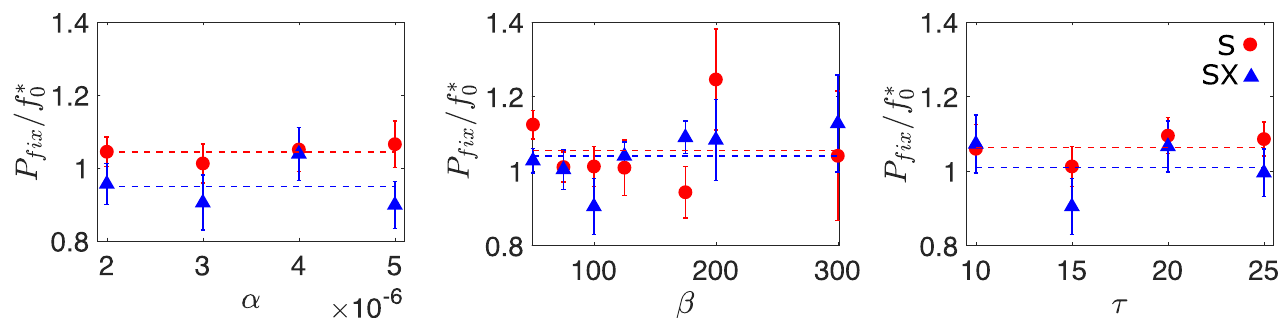
Fig 3. Fixation of neutral mutants. Probability of mutant fixation P in the superinfecting (S) and non superinfection excluding (SX) scenarios, scaled by the fix initial frequency of the mutant f � ¼ 1 = ð V þ b I Þ , as a function of adsorption rate α , burst size β and lysis time τ . Dashed lines indicate the average of the data 0 ss ss for both the superinfecting (blue) and superinfection-excluding (red) scenarios. These lines indicate that neutral mutants in superinfecting populations experience a small advantage over mutants in an equivalent superinfection-excluding population. Unscaled P fix data can be seen in S2 Appendix. Unless otherwise stated, the parameters used were α = 3 × 10 − 6 , β = 100, τ = 15, δ = 0.1 and B 0 = 1000. The error in our estimate of the fixation probability Δ P ffiffiffiffiffiffi p by D P ¼ = n , where n and n fix represent the total number of simulations and the number of simulations where the mutant fixes respectively. The data is n fix fix obtained from a minimum of 14 million independent